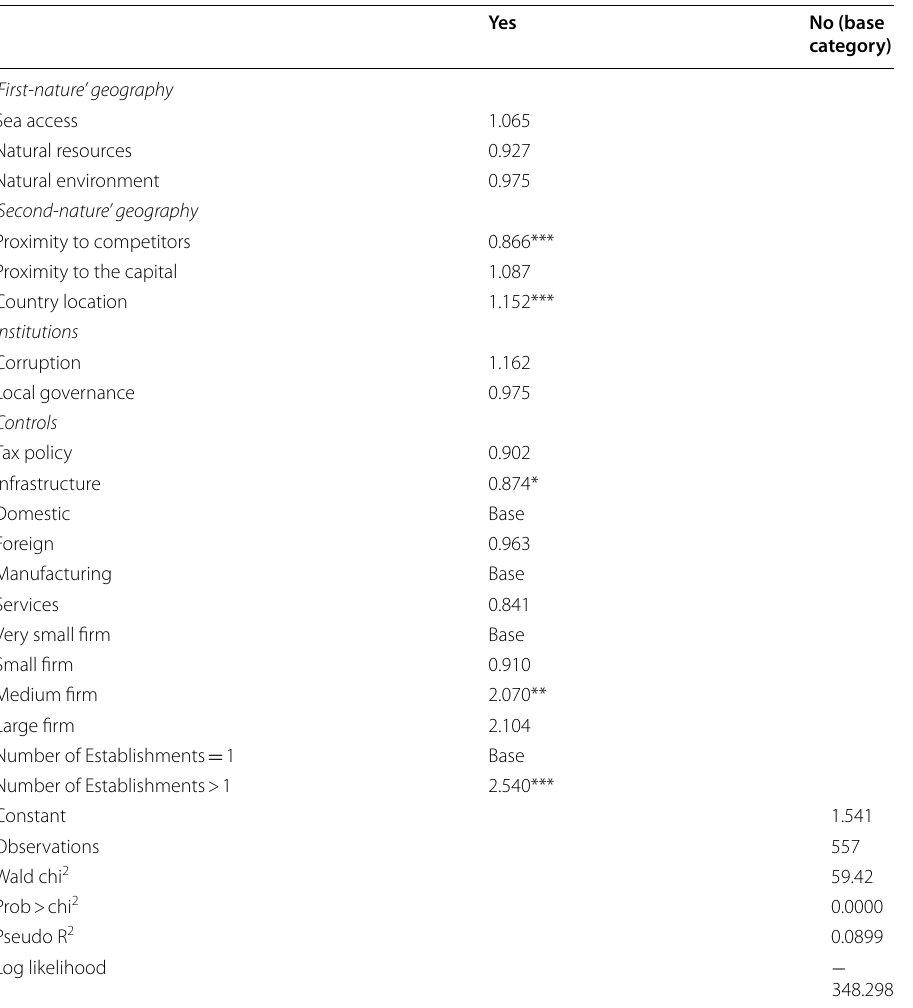
Table 3 Binary logistic regression results for business